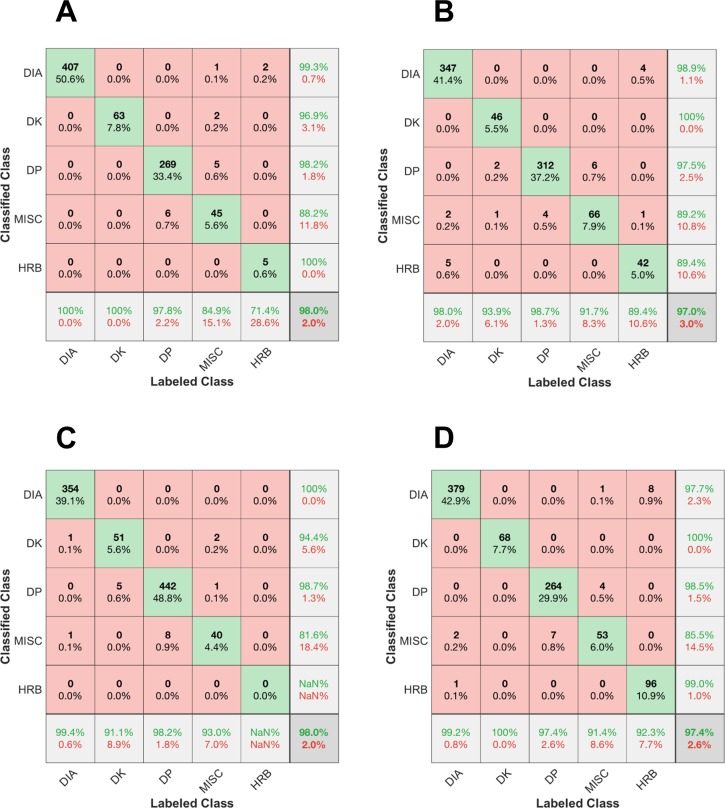
A-D. Validation of sub-technique classification. Confusion matrices for four participants (A-D) while skiing at low intensity (LIT) with the classical sub-techniques diagonal (DIA), kick double poling (DK), double poling (DP), herringbone (HRB), and miscellaneous (MISC). The columns represent cycles labelled as one of the four sub-technique classes by video proof (used as a gold standard), whereas the rows represent cycles classified in each of the four sub-technique classes by the algorithm. The diagonal represents the cycles correctly classified, the bottom row represents the specificity for each sub-technique class, and the right column represents the precision.